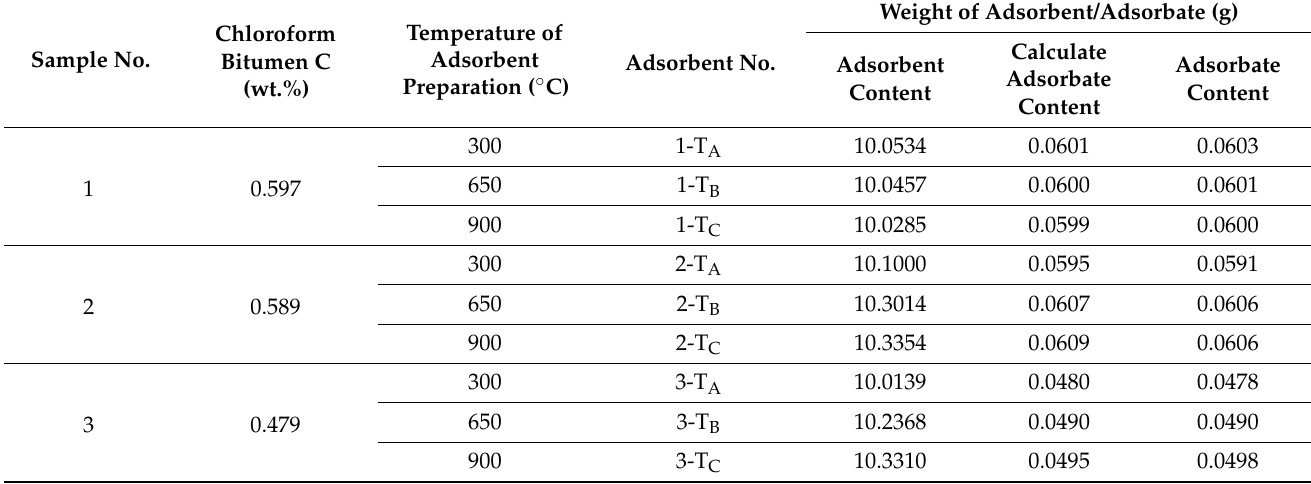
Table 1. Conditions used in the adsorption